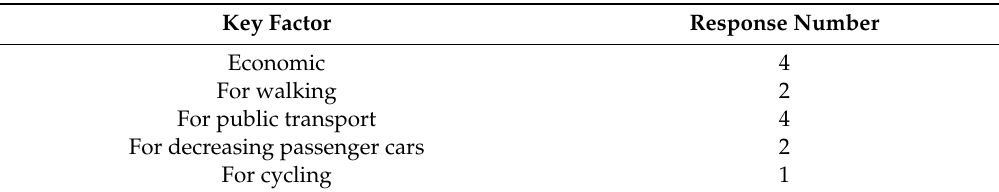
Table A7. Incentives.